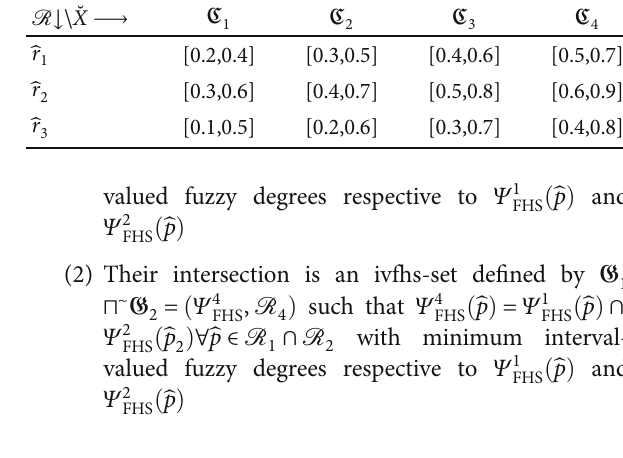
Table 1: Interval-valued fuzzy hypersoft set ð Ψ